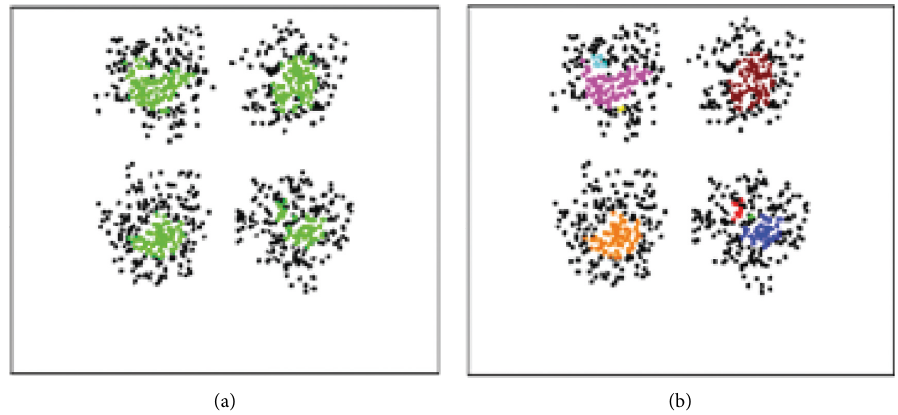
Figure 2: The distribution of dataset B and its clustering effect.